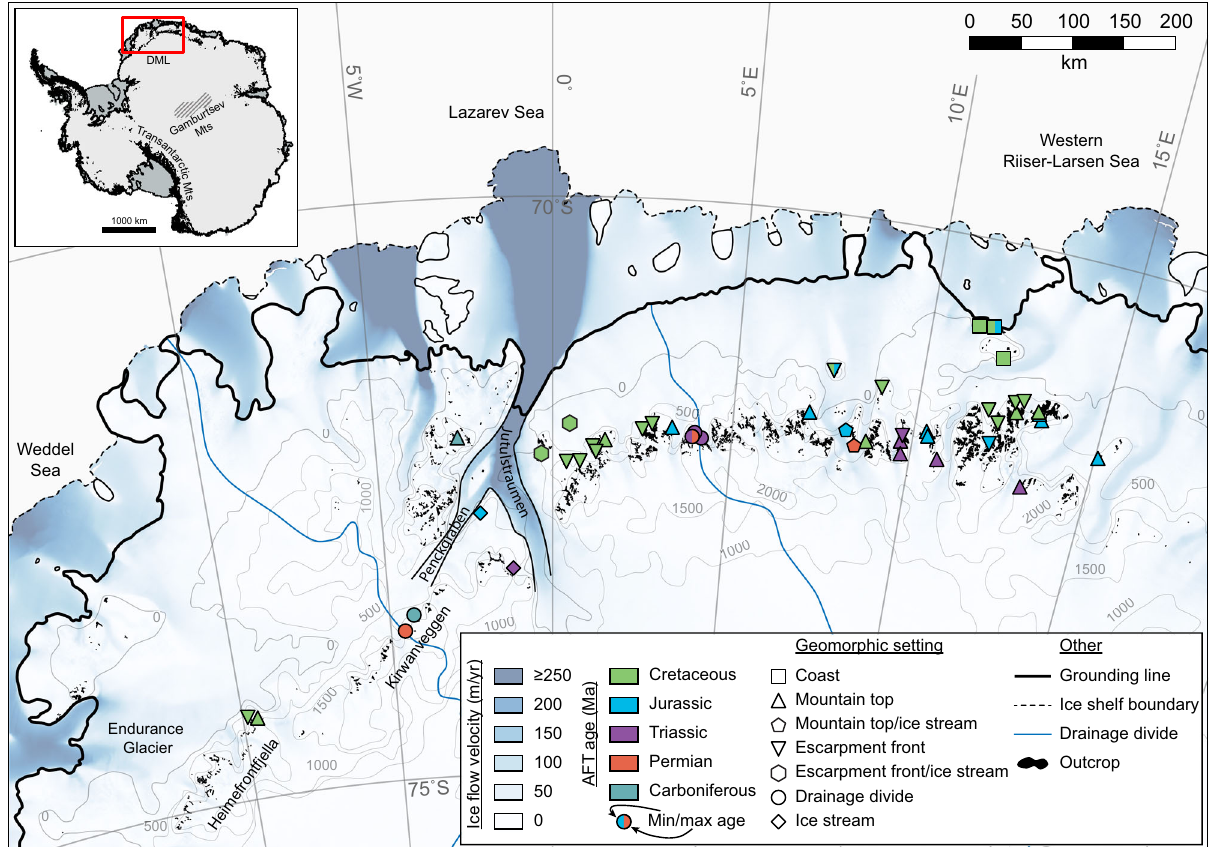
Fig. 1 Sample overview. Overview of samples used in this study, classi fi ed according to their geomorphological position in wDML (west of 5°E) and cDML (east of 5°E). For sample locations where minimum and maximum ages are presented, the ages are from different samples that are in close proximity to each other. Drainage divides 62 , present-day ice fl ow velocities 47,63 and contour lines of the sub-ice topography (based on BEDMAP2 64 ) are obtained from the Quantarctica package 65